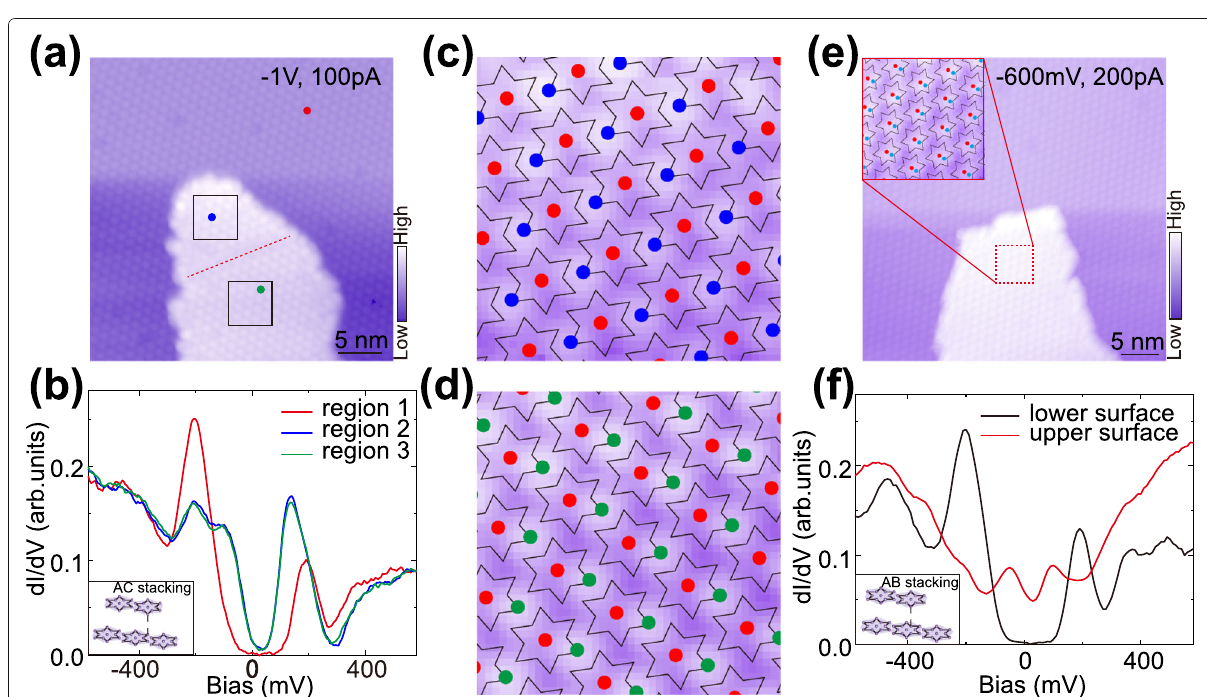
Fig. 5 Two examples of single-step areas in bulk 1 T -TaS 2 , with a small-gap and metallic spectra on the top layer. a and e show the topographies of AC-stacking and AB-stacking single-step areas, respectively. The top left inset in e is the enlargement of the red dotted box. The SD centers in the upper layer are aligned with the SD inner-corner sites (AB-stacking order) in the lower layer. b and f show the top-layer spectra in a and e , which refers to b small-gap spectra and f metallic spectrum. The spectra on bottom terrace are large-gap insulating in both cases. c , d The enlargement of the two black boxes in a . The SD centers in the upper layer are aligned with the SD outer-corner sites (AC-stacking order) in the lower layer. Taken from ref. [59]